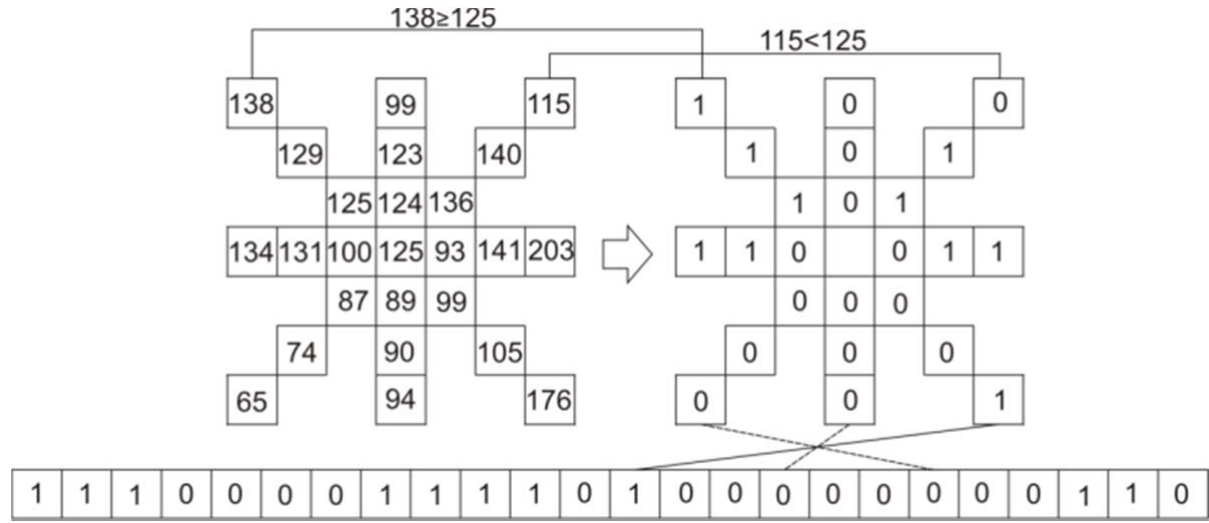
Figure 3. Processing of extended 24-bit local quantized